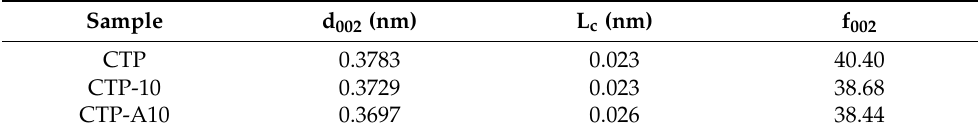
Figure 4. The X-ray diffraction patterns and peak fitting patterns of the original CTP, the air-oxidized CTP, the catalytic air-oxidized CTP. ( a ) Original XRD spectra of CTP, CTP-10, and CTP-A10; ( b ) fitted plot of CTP; ( c ) fitted plot of CTP-10; ( d ) fitted plot of CTP-A10. Table 4. Parameters of XRD spectra.